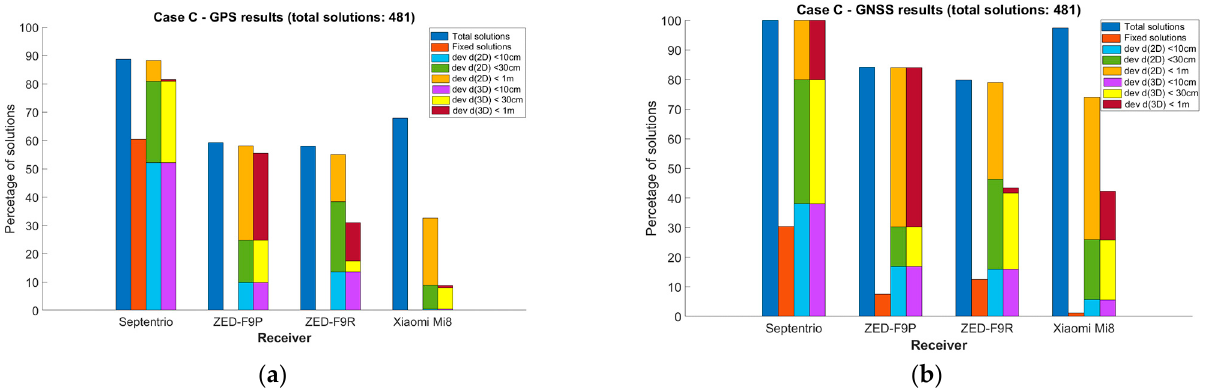
Figure 14. Percentage of solutions for Case C for ( a ) GPS solutions; ( b ) GNSS solutions. Each bar in a group shows: available solutions (1st bar), percentage of fixed solutions (2nd bar), deviation at horizontal distances (3rd bar, where light blue is for thresholds less than 10 cm, green is for thresholds less than 30 cm, and brown is for thresholds less than 1 m), and 4th bar shows deviation at spatial distances (yellow, green, and dark red for 10 cm, 30 cm, and 1 m thresholds, respectively). Table 11. GPS solutions, solutions with fixed ambiguities, and deviation of distances below the given threshold. Situation: Case C—serpentines (no. of total solutions: 481).